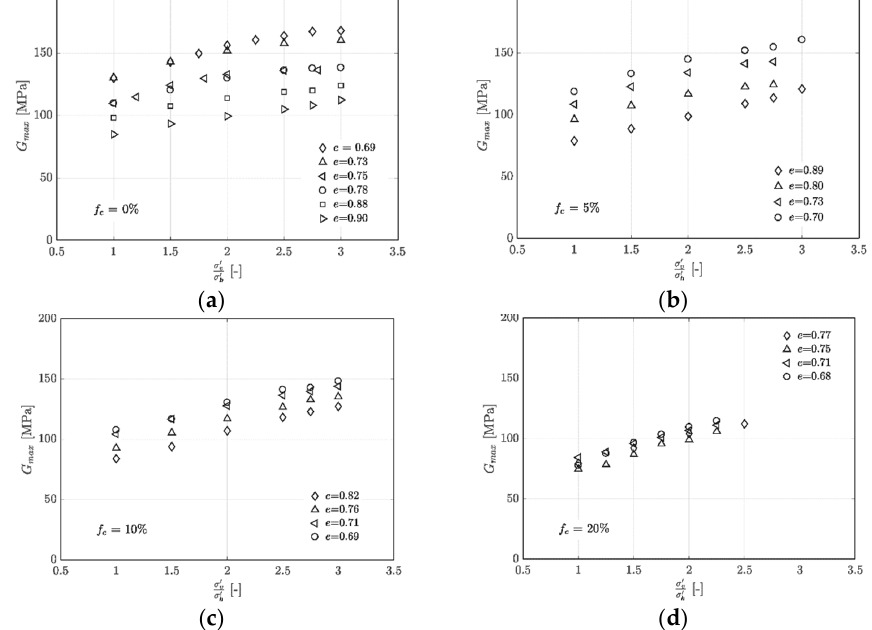
Figure 7. The influence of the anisotropic stress on the G max for ( a ) clean Hostun sand and sand mixed with ( b ) 5%, ( c ) 10% and ( d ) 20% fines,